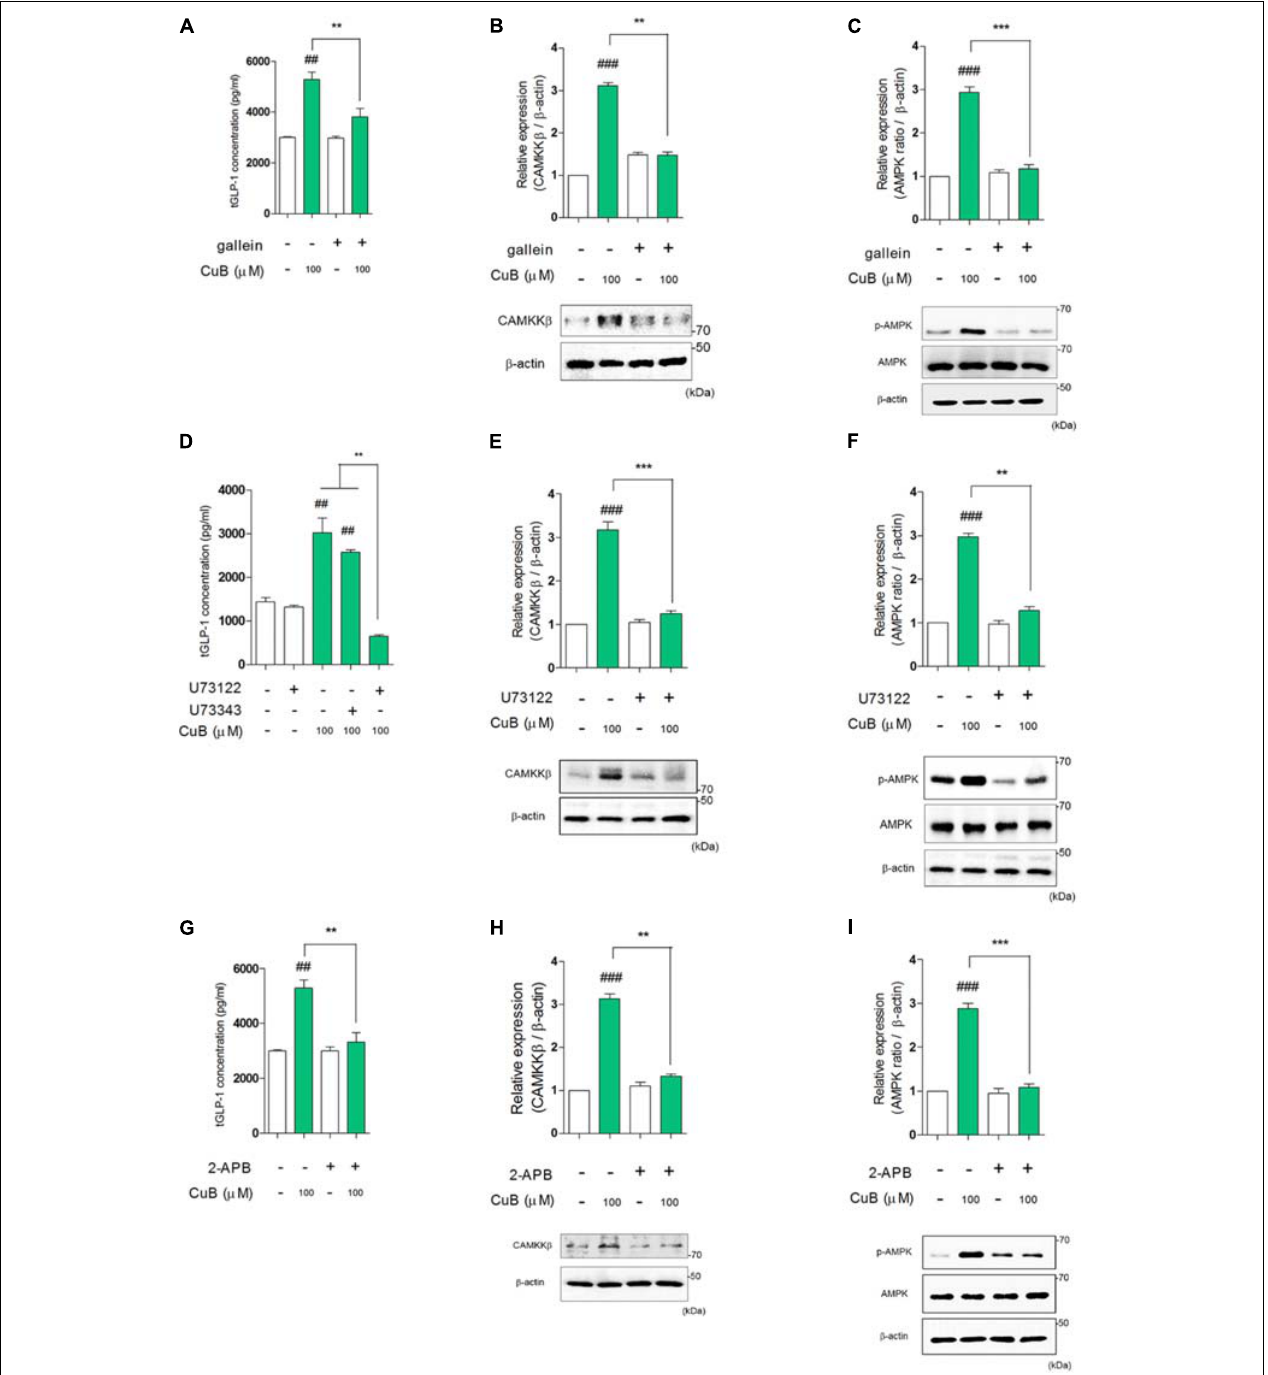
FIGURE 6 | Cucurbitacin B stimulates GLP-1 secretion through G βγ -signaling pathway. (A) CuB-mediated GLP-1 secretion was disturbed under treatment of gallein. Data are presented as a Mean ± SEM, n = 5. ## P < 0.01 vs. control, ∗∗ P < 0.01 vs. Gallein + CuB. (B,C) The protein expression levels of CAMKK β and activation of AMPK were suppressed by Gallein. Data are presented as a Mean ± SEM, n = 5. ### P < 0.01 vs. control, ∗∗ P < 0.01, ∗∗∗ P < 0.001 (CuB) vs. Gallein + CuB. (D) CuB-mediated GLP-1 secretion was disturbed under treatment of U73122. Data are presented as a Mean ± SEM, n = 5. ## P < 0.01 vs. control, ∗∗ P < 0.01 (CuB and CuB + U73343) vs. U73122 + CuB. (E,F) The protein expression levels of CAMKK β and activation of AMPK were suppressed by U73122. Data are presented as a Mean ± SEM, n = 5. ### P < 0.01 vs. control, ∗∗ P < 0.01, ∗∗∗ P < 0.001 (CuB) vs. U73122 + CuB. U73343 is inactive analog of U73122. (G) CuB-mediated GLP-1 secretion was disturbed under treatment of 2-APB. Data are presented as a Mean ± SEM, n = 5. ## P < 0.01 vs. control, ∗∗ P < 0.01 vs. 2-APB + CuB. (H,I) The protein expression levels of CAMKK β and activation of AMPK were suppressed by 2-APB. Data are presented as a Mean ± SEM, n = 5. ### P < 0.01 vs. control, ∗∗ P < 0.01, ∗∗∗ P < 0.001 (CuB) vs. 2-APB +